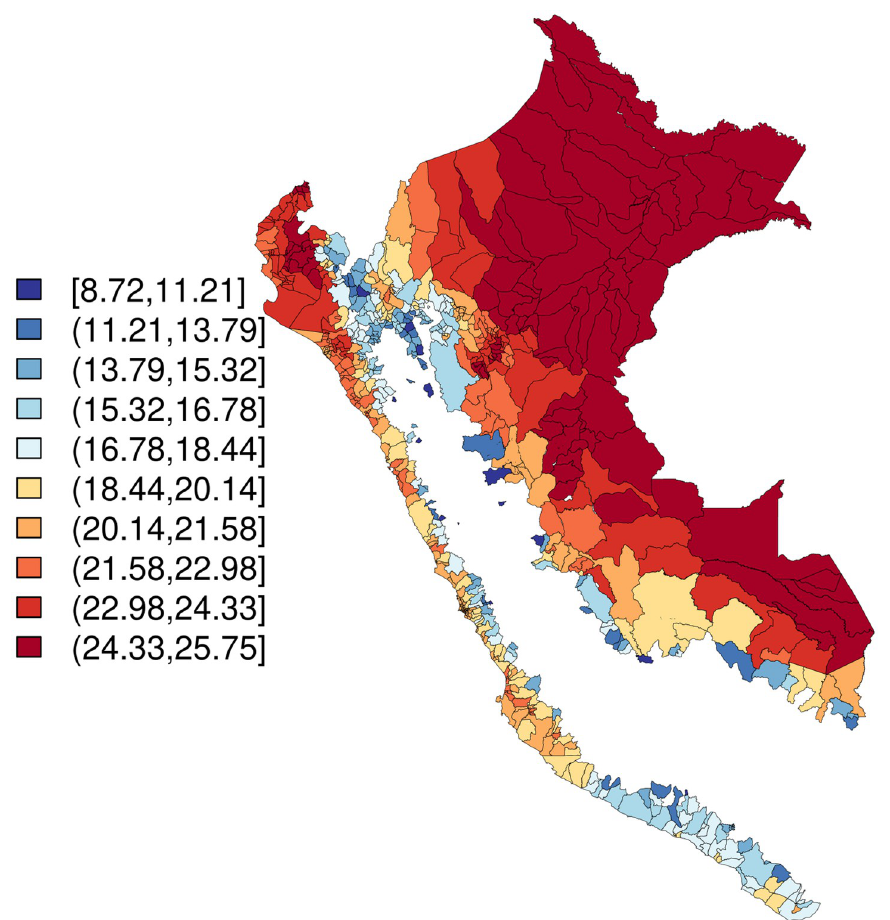
Fig 3. Temperature (mean over time; ˚C), merged districts in Peru (n = 1,834), January 2000-September 2018. Base map source: GEOSS Information Exchange Data Hub,